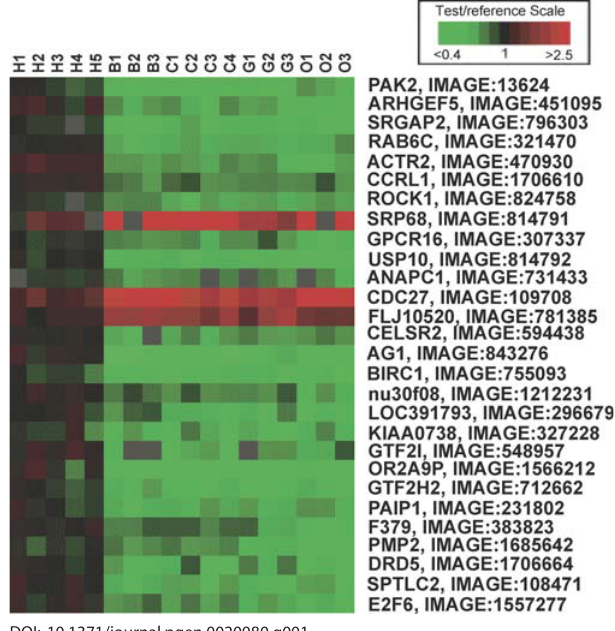
Figure 1. TreeView Image Showing cDNA aCGH Results for Potential Cognition/Brain-Related HLS Genes Brain-related genes listed were obtained from 140 genes predicted by cDNA aCGH to show an HLS change in copy number [34]. H, human; B, bonobo; C, chimpanzee; G, gorilla; O,